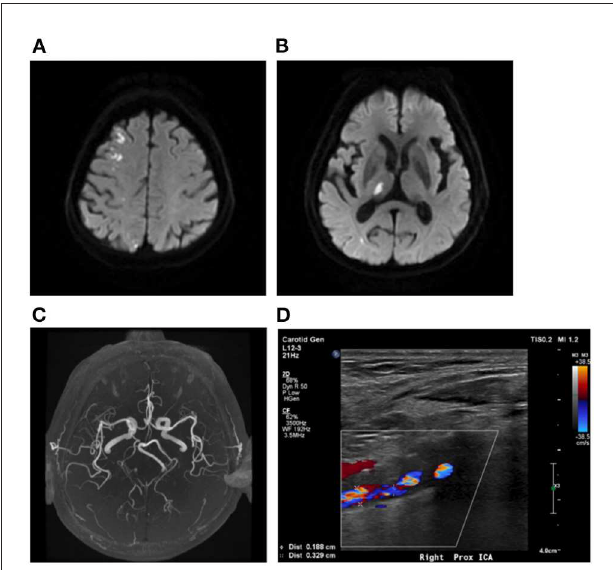
FIGURE1 Multiple infarcts caused by variation of large artery. A 75-year-old man presented with weakness in left upper and lower limbs at onset with infarcts located at right frontal lobe and thalamus (A, B) . MRA showing right fetal-type posterior artery (C) , and the carotid artery ultrasound showing severe stenosis of proximal right ICA (D) . MRA, magnetic resonance angiograph; ICA, internal carotid artery.